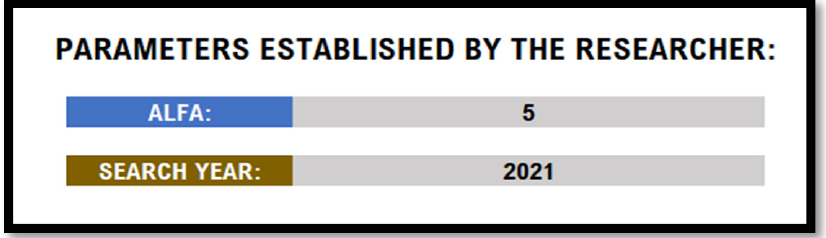
Figure 4. Methodi Ordinatio Parameters.